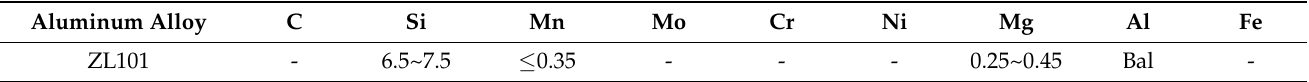
Table 1. Chemical composition of the ZL101 aluminum alloy